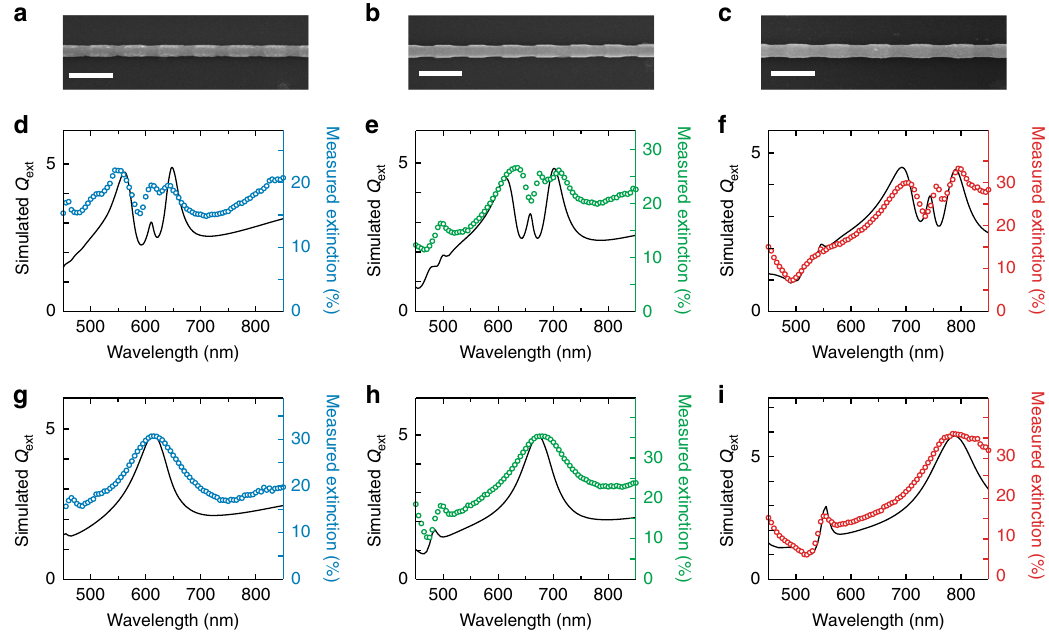
Fig. 2 Experimental extinction spectra of NW GSLs. a – c SEM images of three NW GSL with geometrical parameters of d = 130 ± 1 nm, e = 114 ± 1 nm, p = 397 ± 10 nm ( a ), d = 145 ± 1 nm, e = 119 ± 5 nm, p = 383 ± 9 nm ( b ), and d = 158 ± 1 nm, e = 134 ± 2 nm, p = 465 ± 10 nm ( c ); scale bars, 500 nm. d – i Extinction spectra of NW GSLs ( d – f ) and of uniform NWs of the same diameters ( g – i ), showing experimentally measured extinction (colored circles and right-hand axes) and numerically simulated Q ext (black lines and left-hand axes). Spectra in d – f correspond to the images in a – c , in Fig. 2d – i for GSLs (Fig. 2d – f) and uniform NWs of the same diameters (Fig. 2g – i). Each spectrum shows a broad Mie resonance that shifts to longer wavelengths with increasing diameter. For the GSLs, sharp spectral features deviating from the background Mie resonances are observed. Numerical simulations (black solid lines) of the extinction ef fi ciency ( Q ext ) that use geometrical parameters obtained from the SEM images and include the focused laser beam (see Methods) agree well with the experimental measurements, con fi rming the presence of Mie-BGS coupling and a scattering dark state in these nanostructures. However, the simulations also reveal several differences between focused excitation and the plane wave excitation modeled in Fig. 1. First, the simulations predict a scattering dip with a substantially larger linewidth, which can be attributed to the localized excitation causing a broader distribution of Fourier spatial components to couple to the BGS. Second, the simulations predict an extinction peak within the dip, which can be attributed to mode distortion caused by the fi nite number of GSL periods excited by the focused beam. Mode degradation in truncated arrays is a common phenomenon observed in planar metamater- ials due to loss of coherence 37,38 . In our case, the fi nite beam prevents the Bloch condition along the GSL from being satis fi ed, causing incomplete formation of the BGS and an increase in scattering loss, manifesting as a peak within the scattering dip (Supplementary Fig. 10).